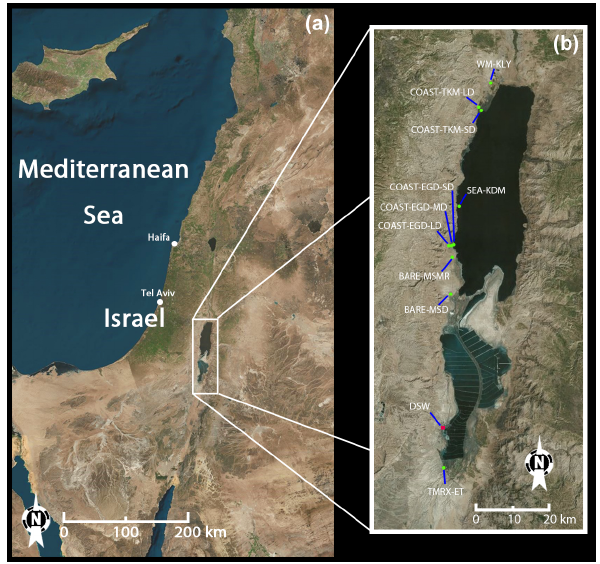
Figure 1. Location and satellite image of the Dead Sea measure- ment sites (see Sect. 2.1.2) and Dead Sea Works (DSW). (a) Loca- tion of the Dead Sea. (b) Zoomed view of the area of the measure- ment